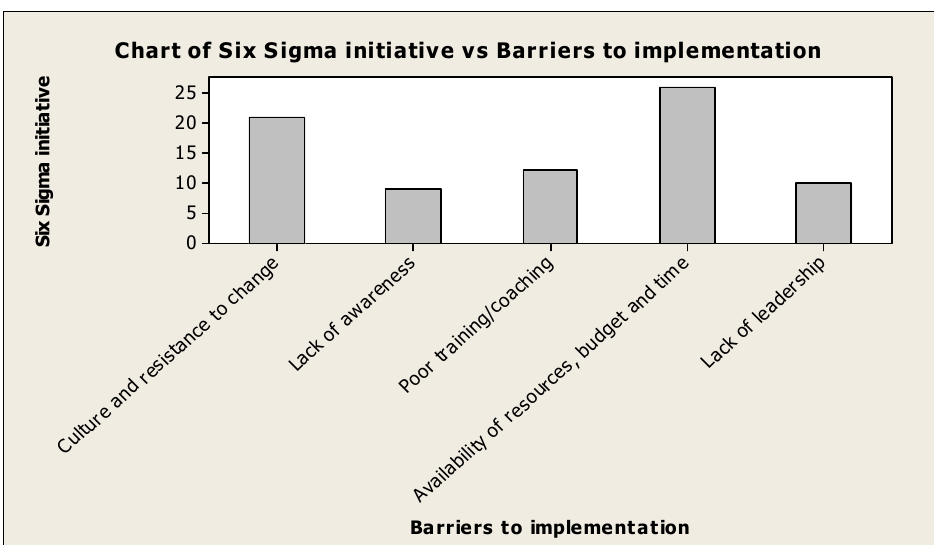
Figure 3 – Barriers to implementation of Six